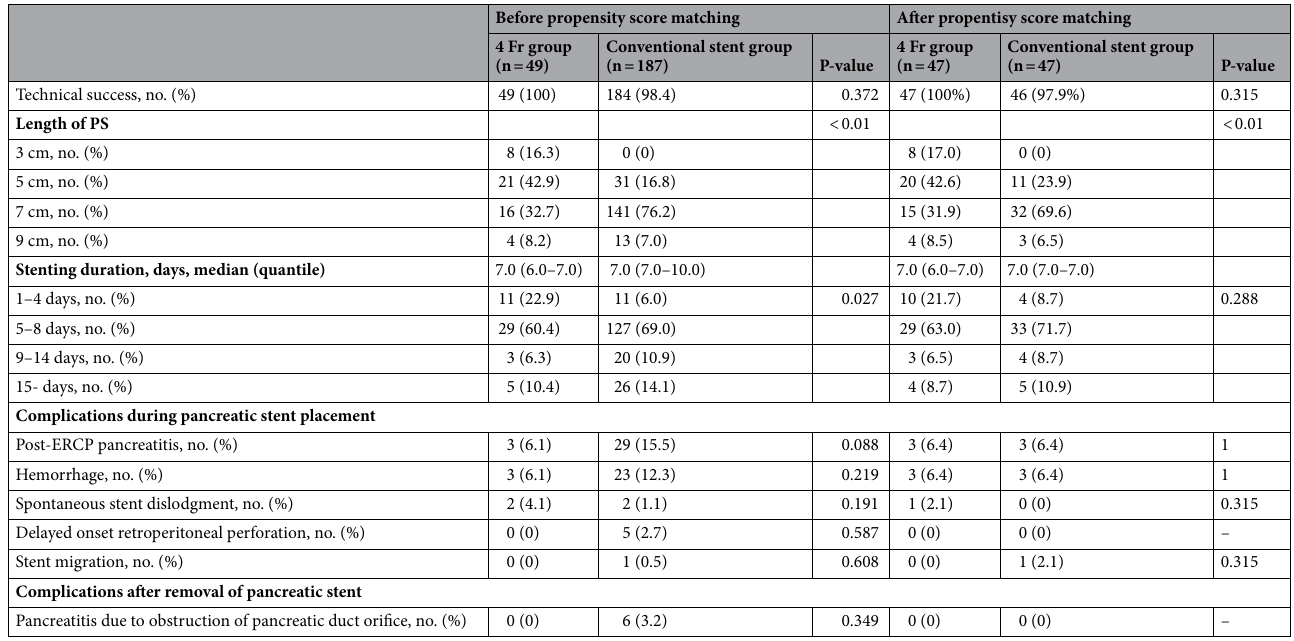
Table 3. Outcomes of pancreatic stent placement in each group. PS, plastic stent.